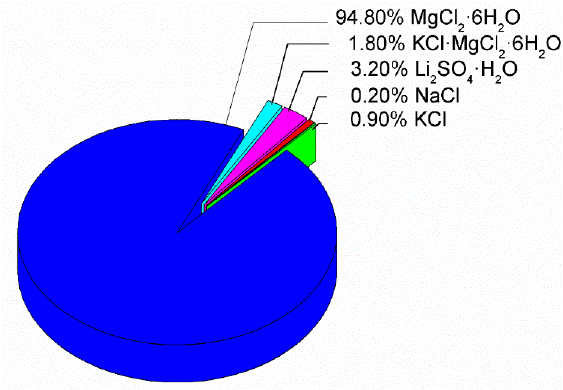
Figure 4. Mineralization results of a bischofite sample [25], indicating the presence of about 95% of magnesium chloride hexahydrate and 5% of impurities based on inorganic salts.